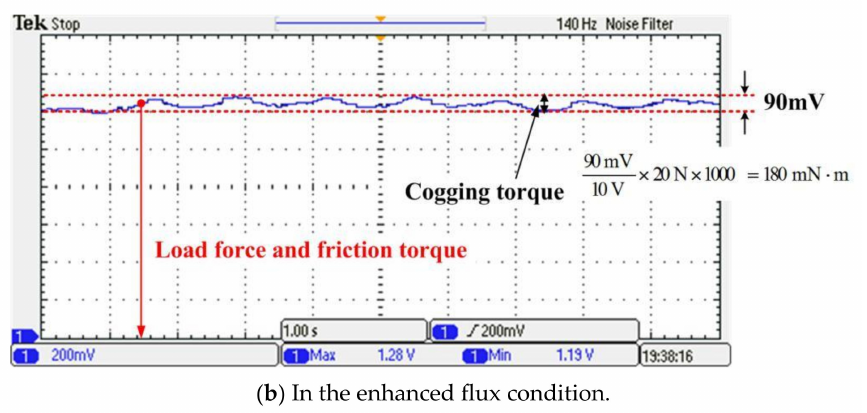
Figure 11. Test results of cogging torque of the VFMPM machine in the load condition. ( a ) In the weakened flux condition; ( b ) In the enhanced flux